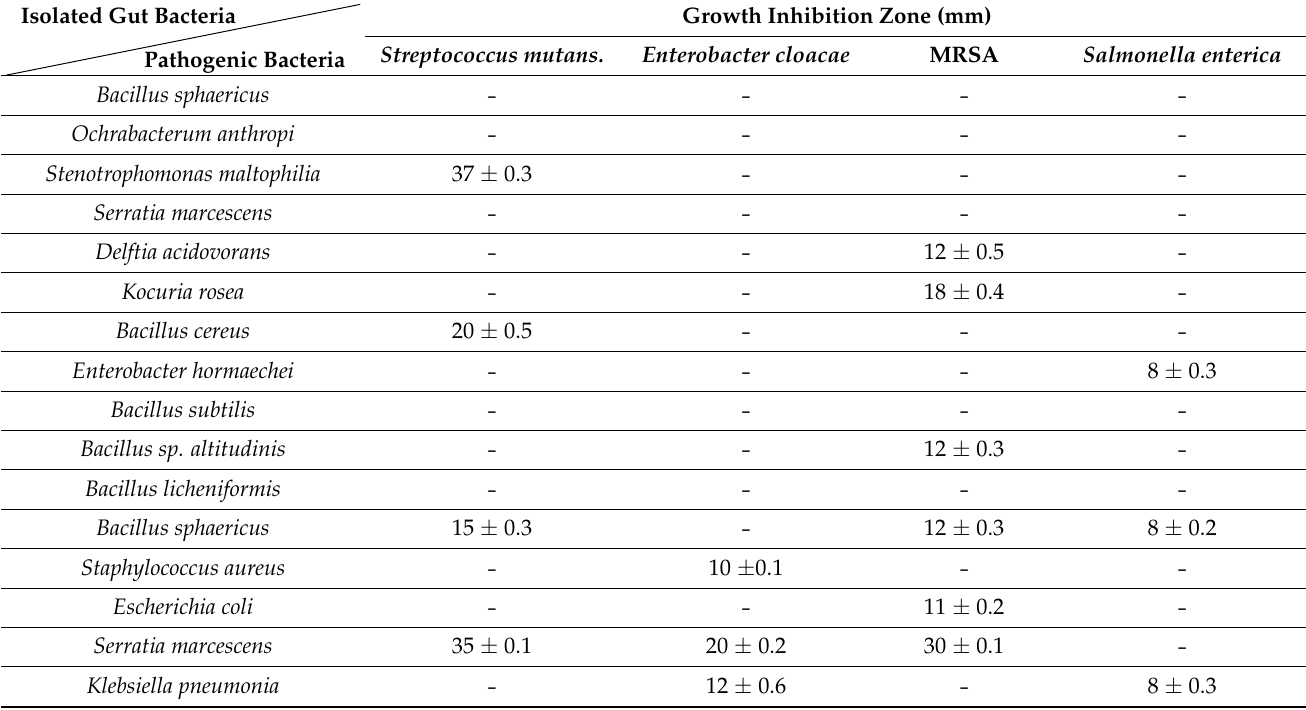
The numbers represent means ± standard deviations. (-) absence of